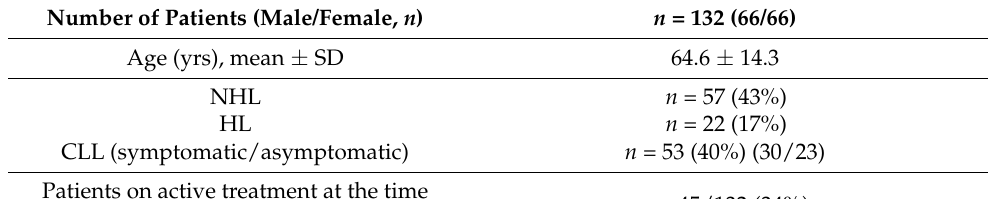
Table 1. Characteristics of patients with